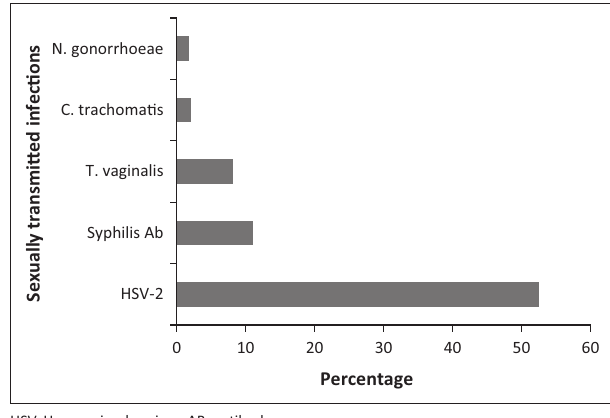
FIGURE 1: Prevalence of sexually transmitted infections ( n = 365).